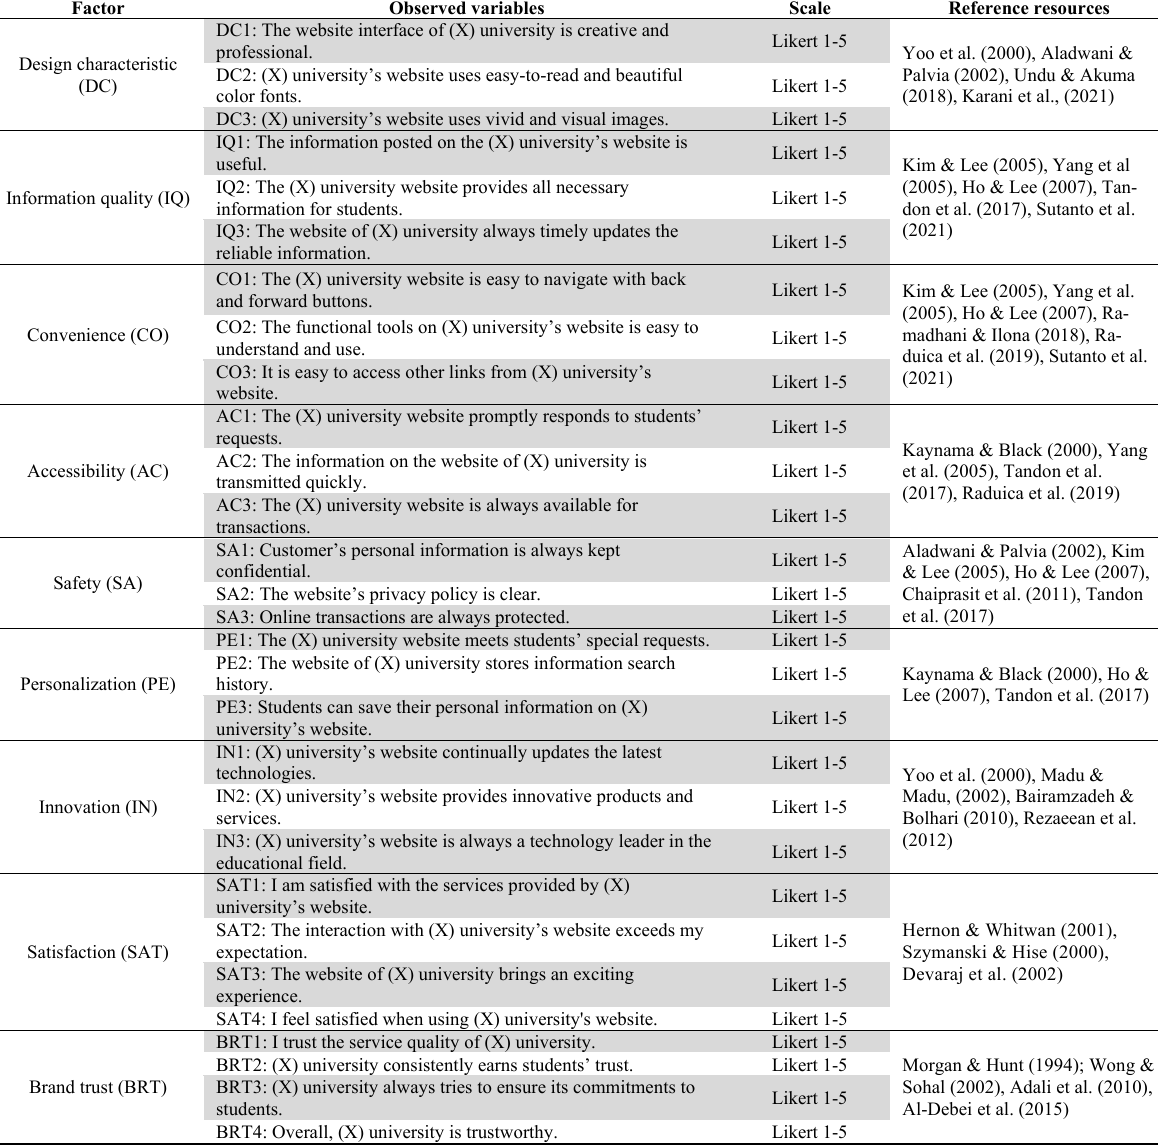
Interpretation of observed variables in the research model